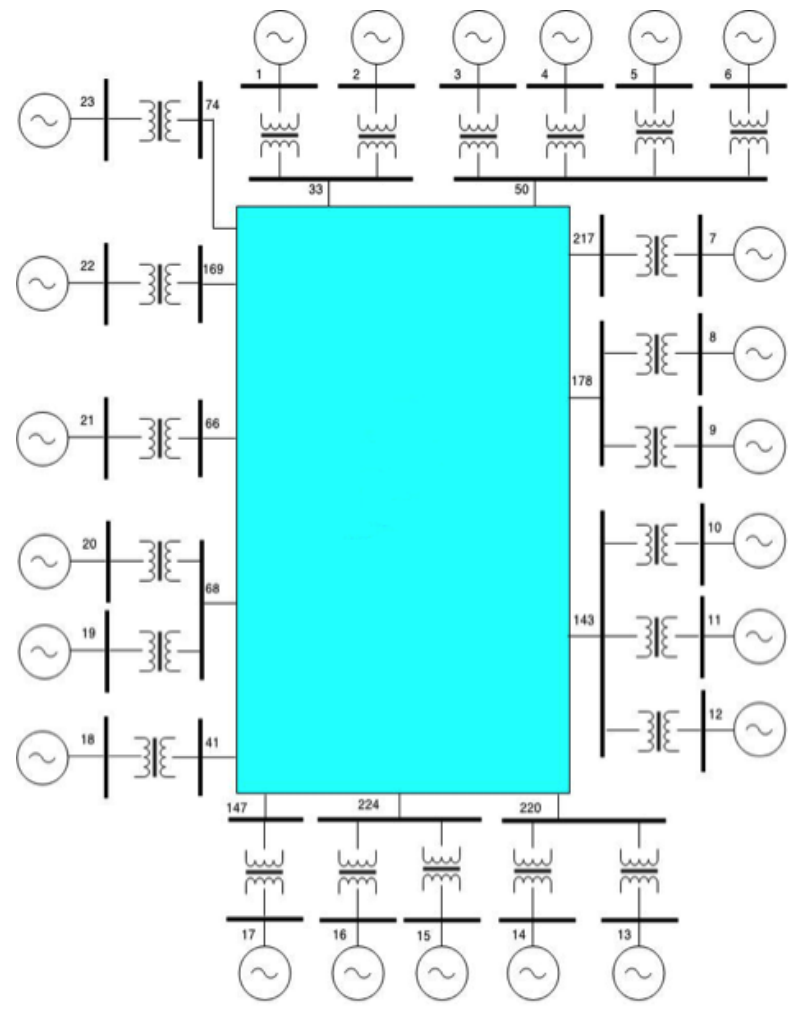
Figure 11. Chilean Northern Interconnected Power System.